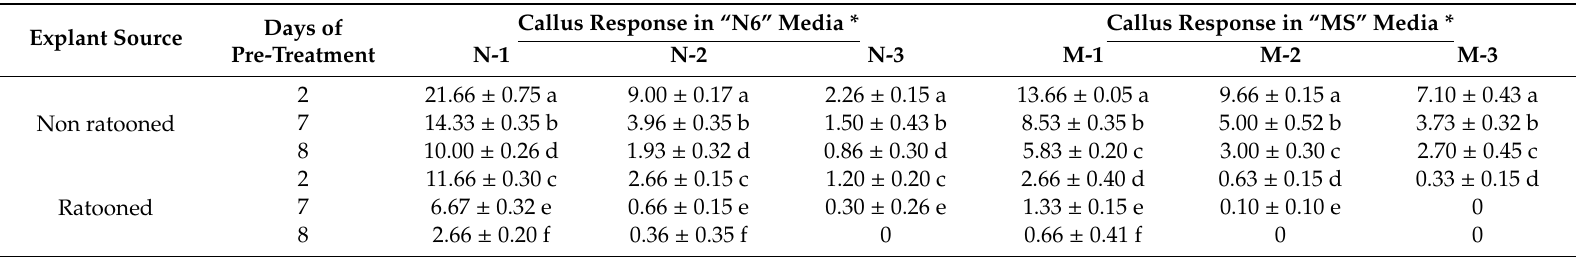
Table 1. Response of PGRs in two basal media (N6 and MS) with duration of cold pre-treatment on callus induction in non-ratooned and ratooned anthers of